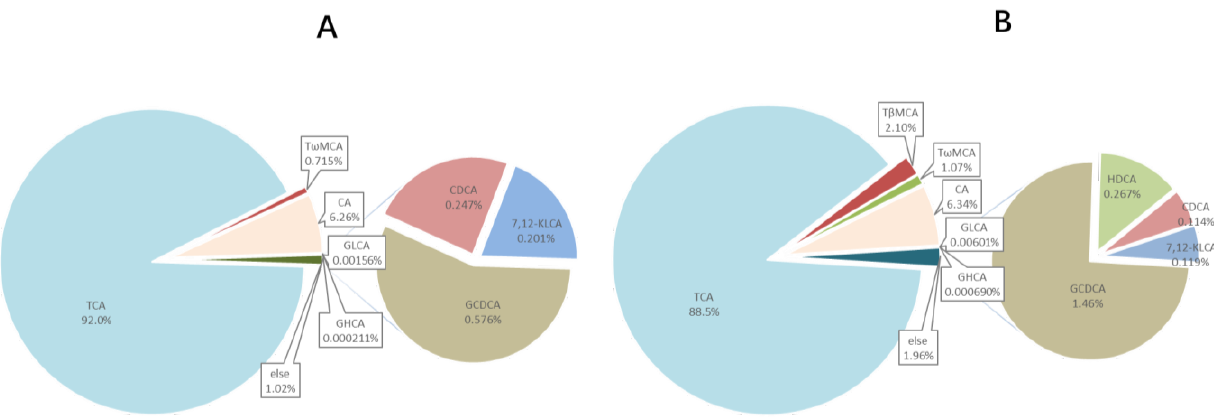
Figure 5. Bile acids species composition in bile, ( A , B ) for HP and HP+BAs, respectively ( n = 7). TCA is the major BA of carp. Compared to HP group carp, the ratio of GCDCA, T β MCA, GLCA, and HDCA increased significantly in HP+BAs group, while TCA and CDCA